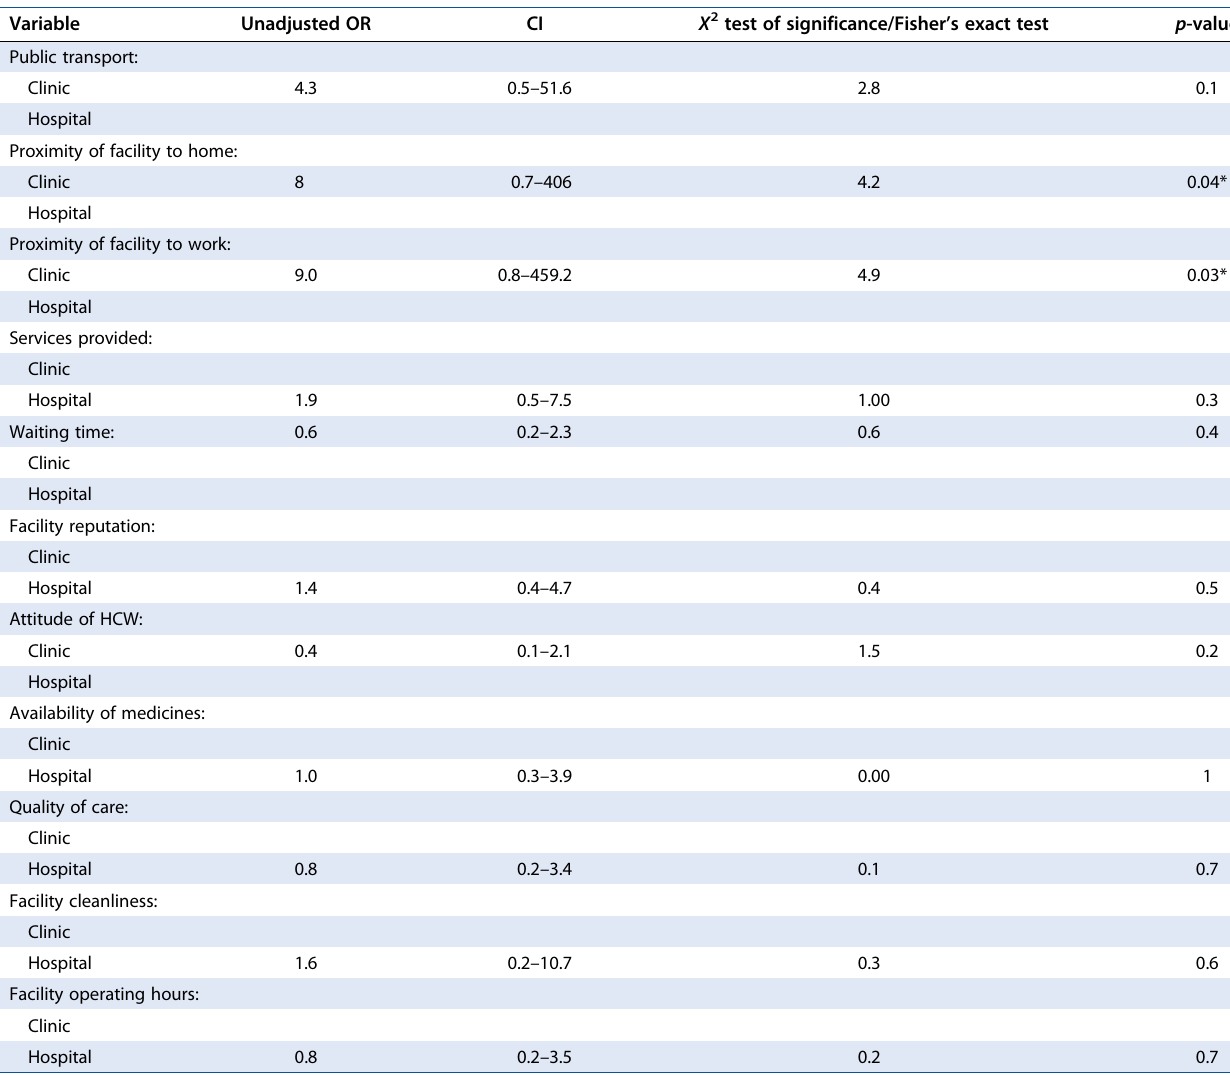
Table 4: Analysis of institutional factors between referrals and self-referrals in eThekwini district and district/regional hospitals between May and June 2015